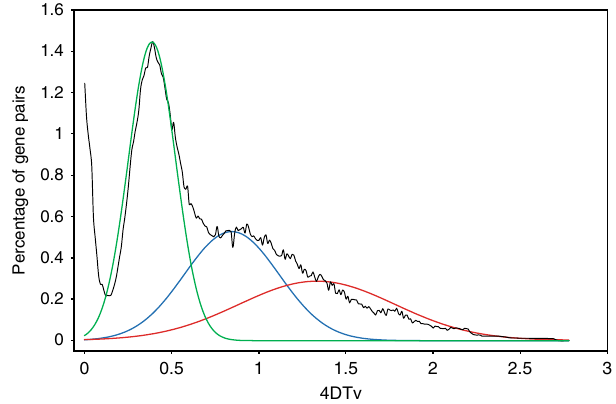
Fig. 8 Whole-genome duplications in the mangrove HSC genome. 4DTv analysis showing the relative age of paralogues in the mangrove HSC genome. Three peaks were identi fi ed using the Bayesian information criterion. The populations under red, blue, and green curves represents 4DTv values of paralogue pairs belonging to the fi rst, second, and third rounds of WGD,